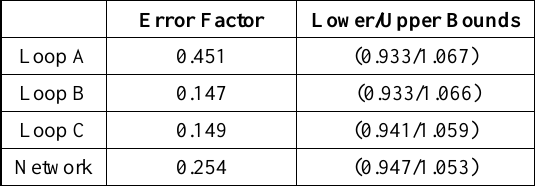
Table 3. Error factor for 3 loops and a network from precise levelling